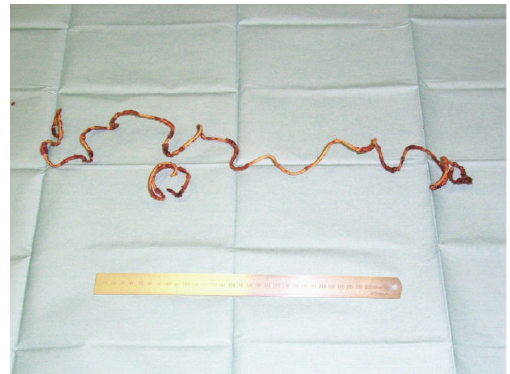
Figure 3: The vinyl tube was approximately 140cm in